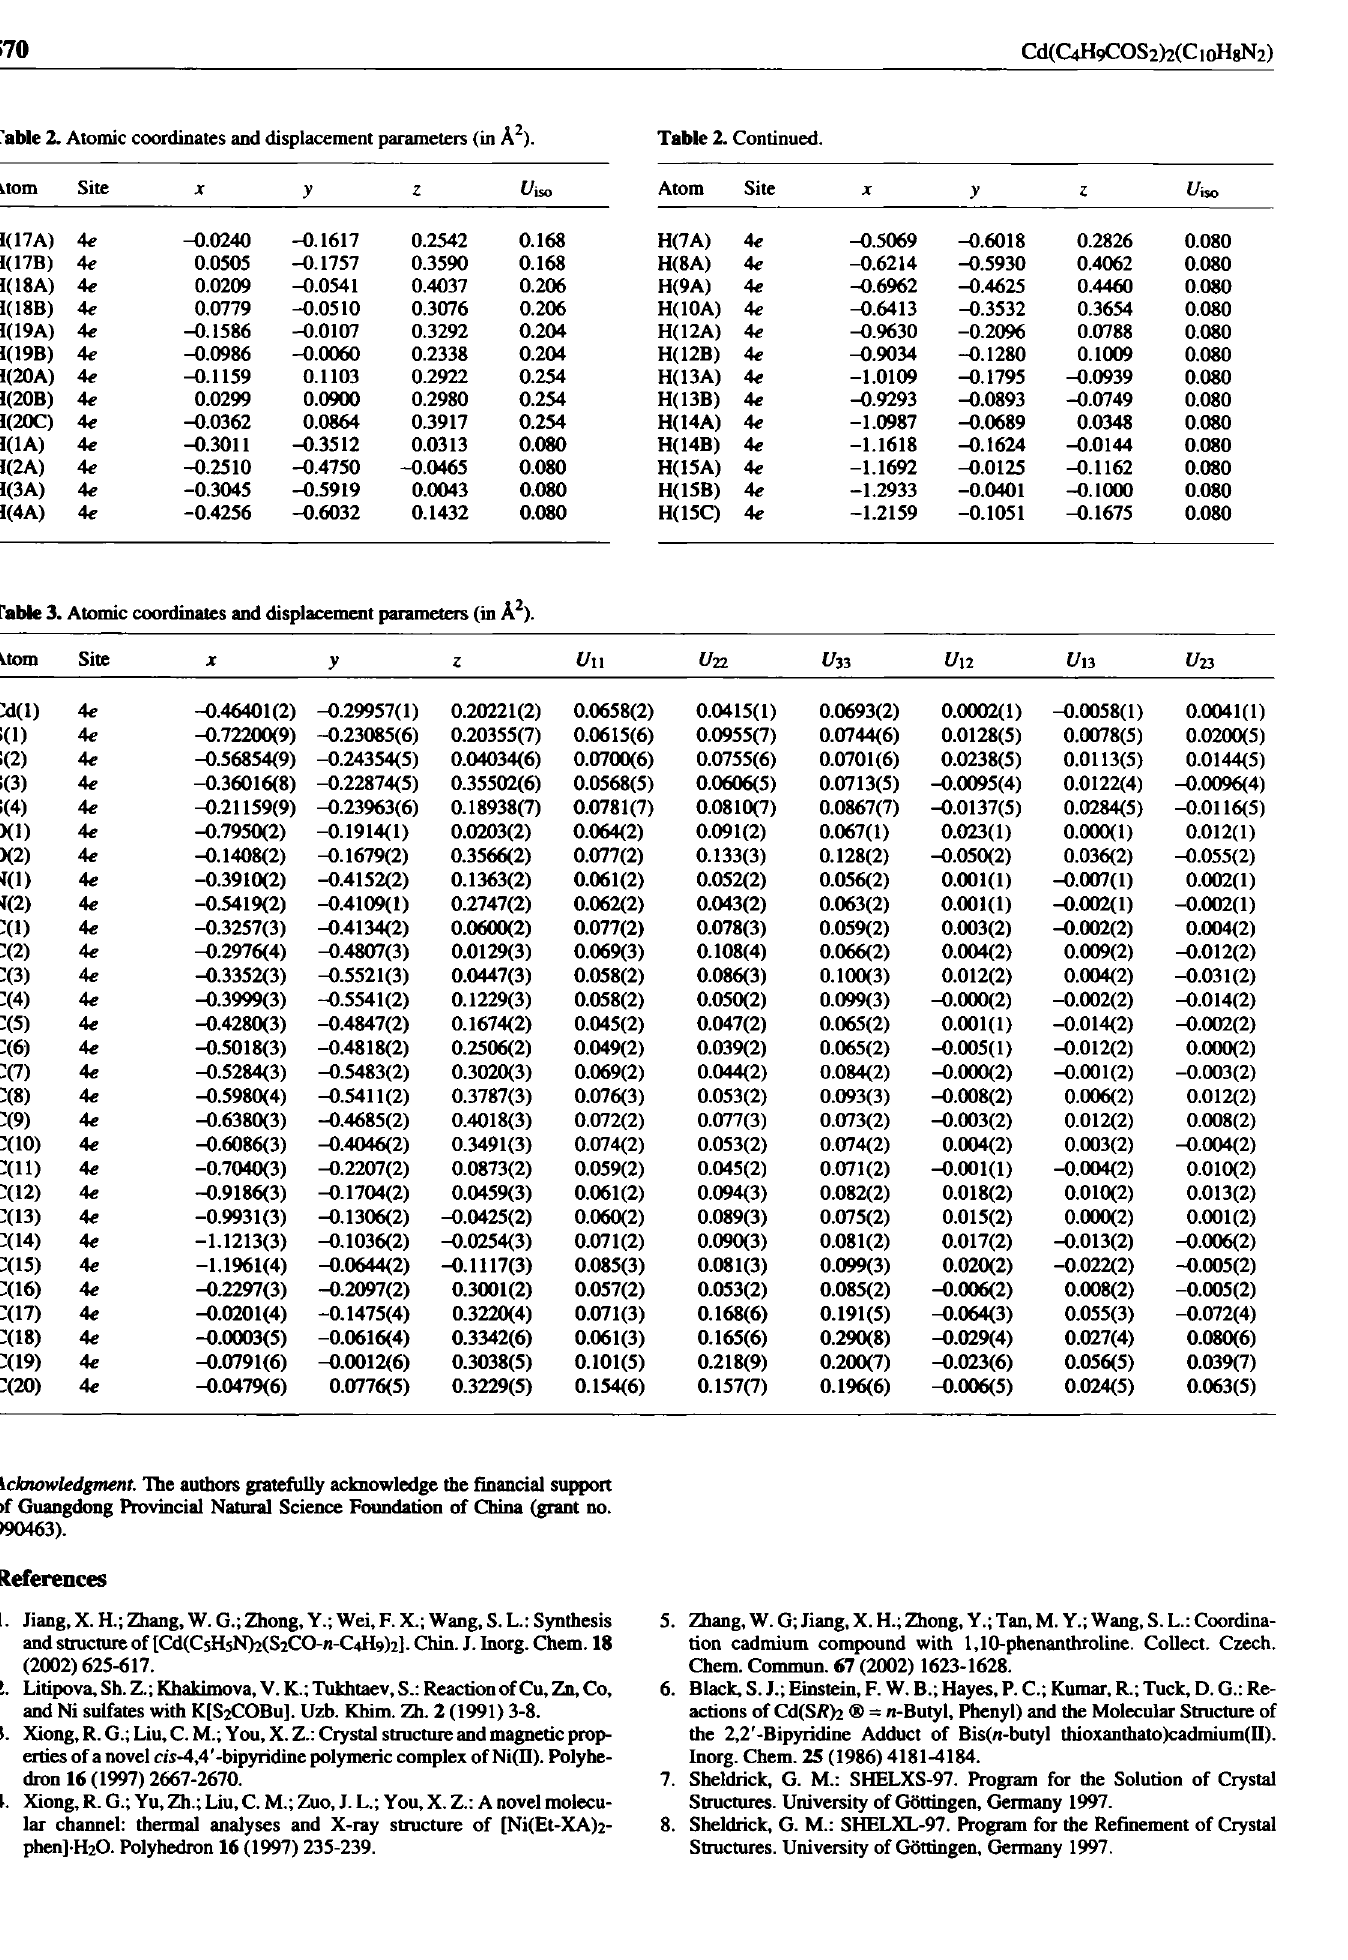
Table 2. Atomic coordinates and displacement parameters (in A 2 ).